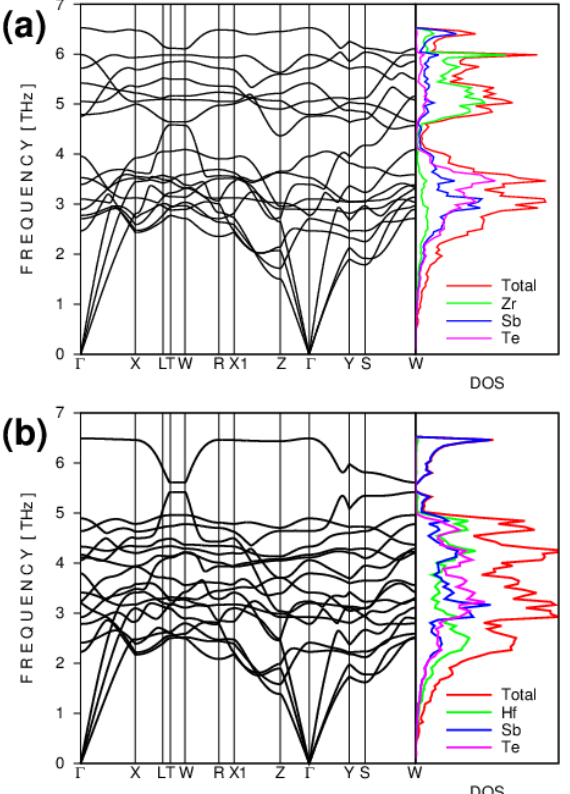
Figure 3. Phonon band structures and phonon densities of states ( a ) ZrSbTe, ( b ) Figure 3 . Phonon band structures and phonon densities of states ( a ) ZrSbTe, ( b ) HfSbTe . It can be observed from Figure 3 that for higher frequency (above 3.5 THz), all the modes are optics. For the frequency between 3.5 and 2.5 THz, the modes correspond to both acoustic and optical modes while for lower frequency (below 2.5 THz), there are only